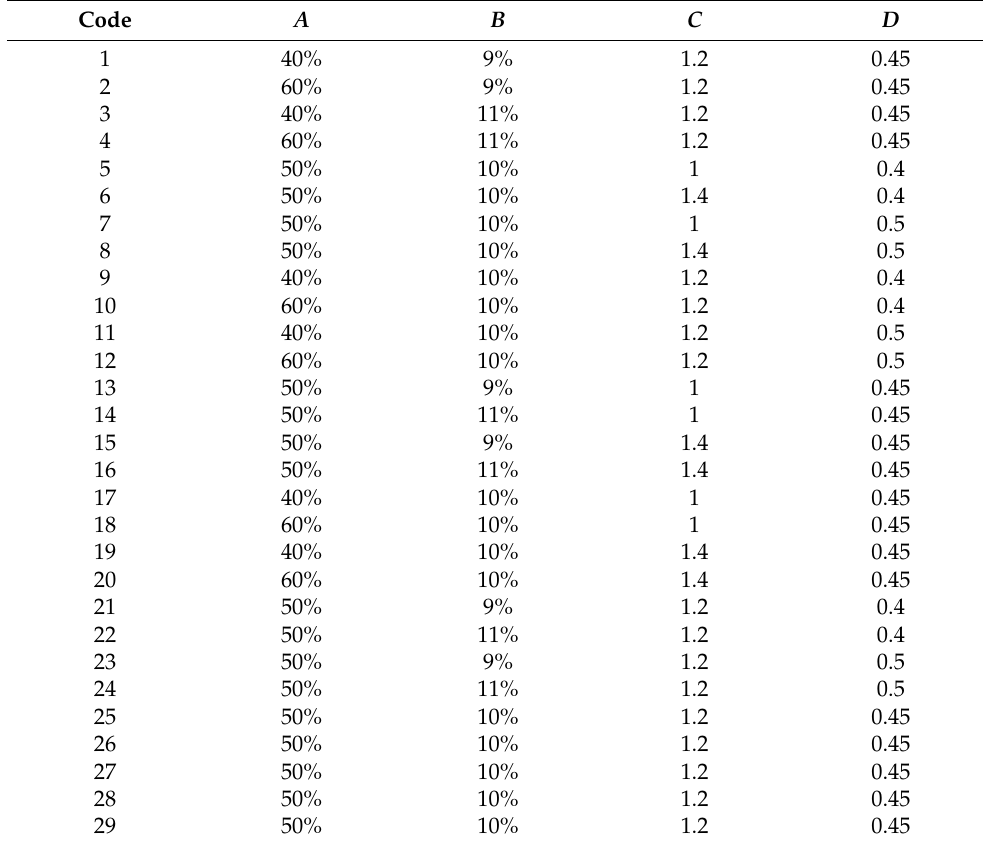
Table 5. Geopolymer synthesis mixture